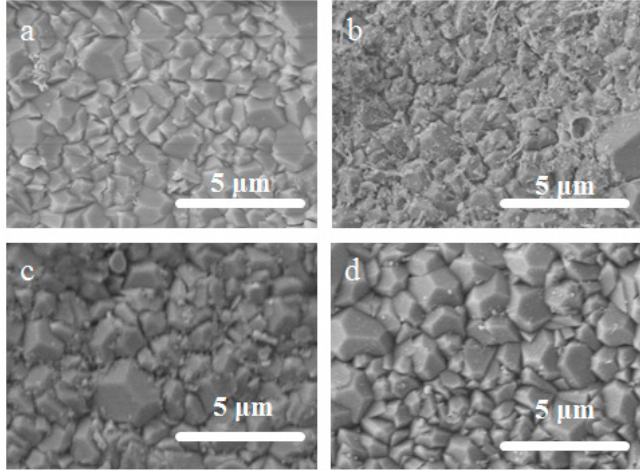
Figure 4. SEM images of NaA zeolite membrane surface morphologies treated by ( a ) CaCl 2 , ( b ) BaCl 2 , ( c ) ZnCl 2 and ( d ) MgCl 2 solutions.